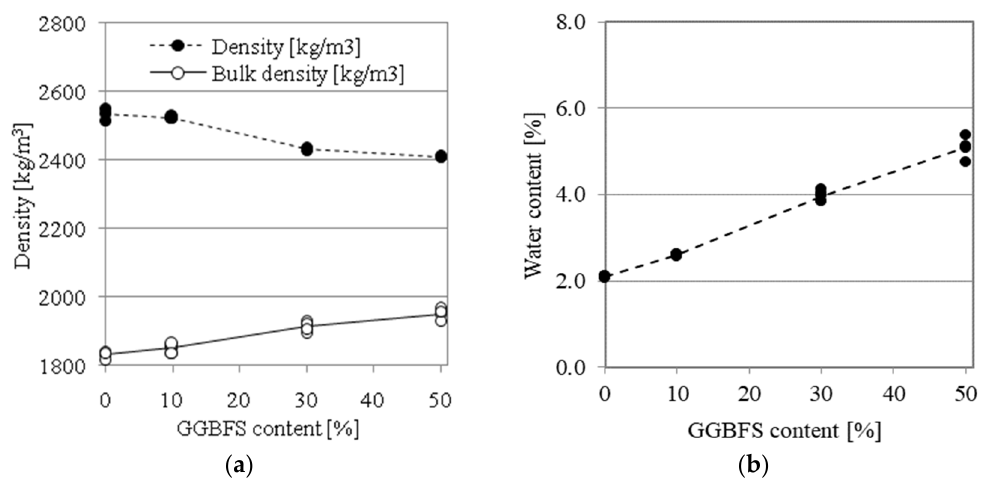
Figure 5. The effect of GGBFS content on the physical properties of AA mortars: ( a ) density; ( b ) initial water content.